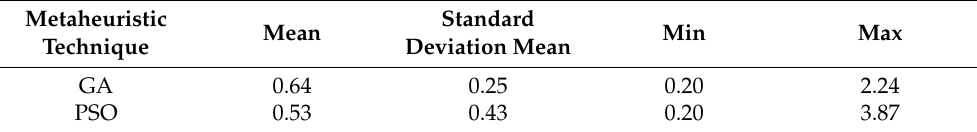
Table 3. Statistical values of FRC (mg/L) from the last 24 h of simulation in all nodes. Metaheuristic Technique